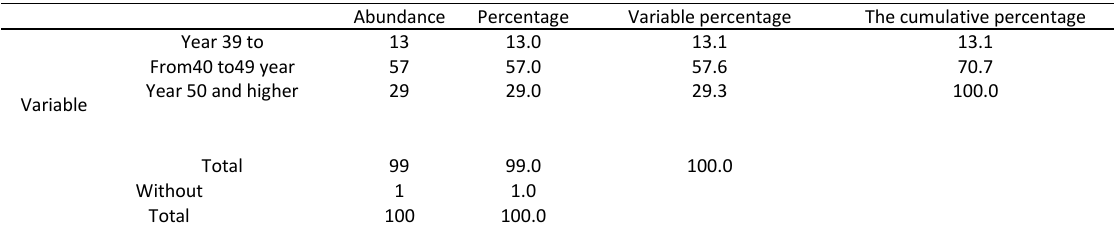
Table 4: Age composition